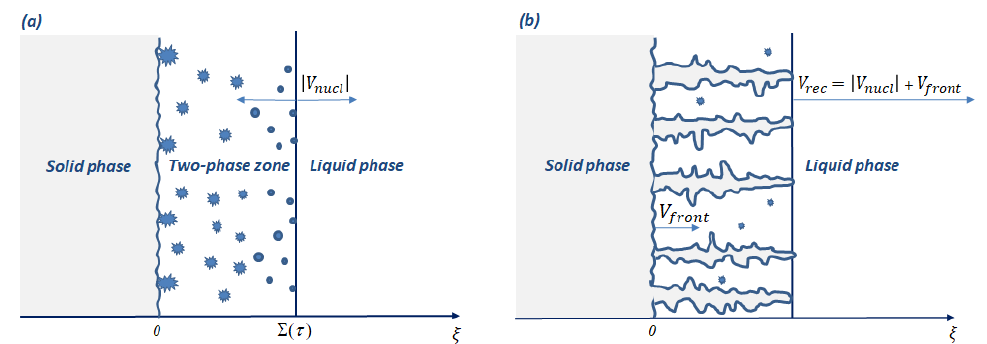
Figure 2. An illustration showing the moving two-phase zone along the spatial coordinate ξ at time τ . Panel ( a ) demonstrates the bulk phase transition process described in Section 2. Panel ( b ) illustrates a combined effect of the bulk and crystallization from an undercooled